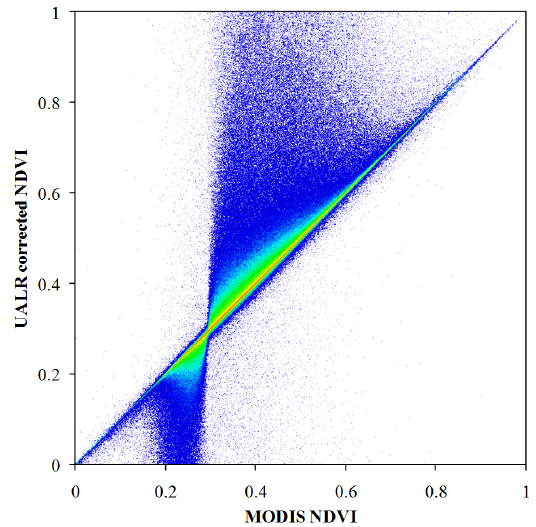
Figure 8. The scatter plot of all valid pixels for MODIS NDVI and UALR-adjusted NDVI for early June